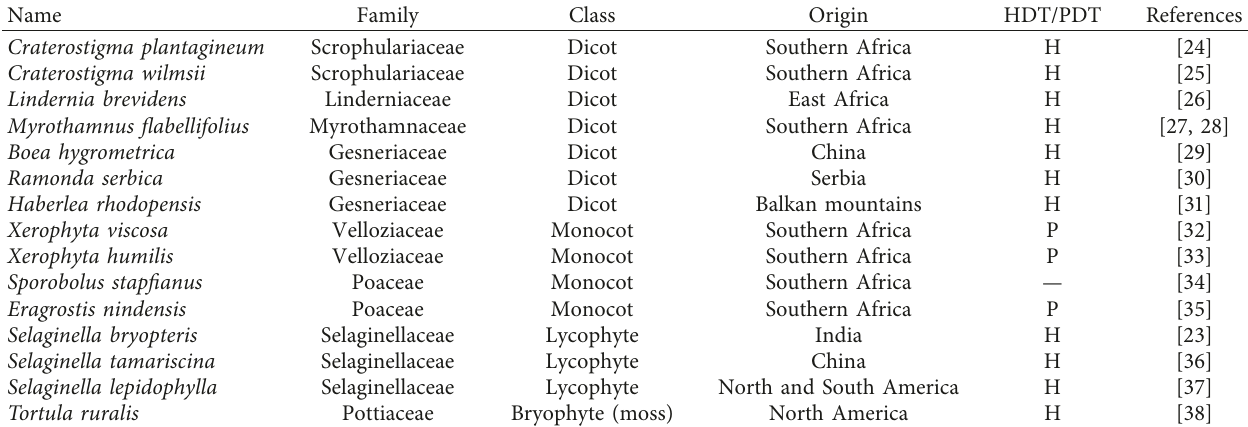
Table 1: Classification of DT plants according to the types, family, class, and